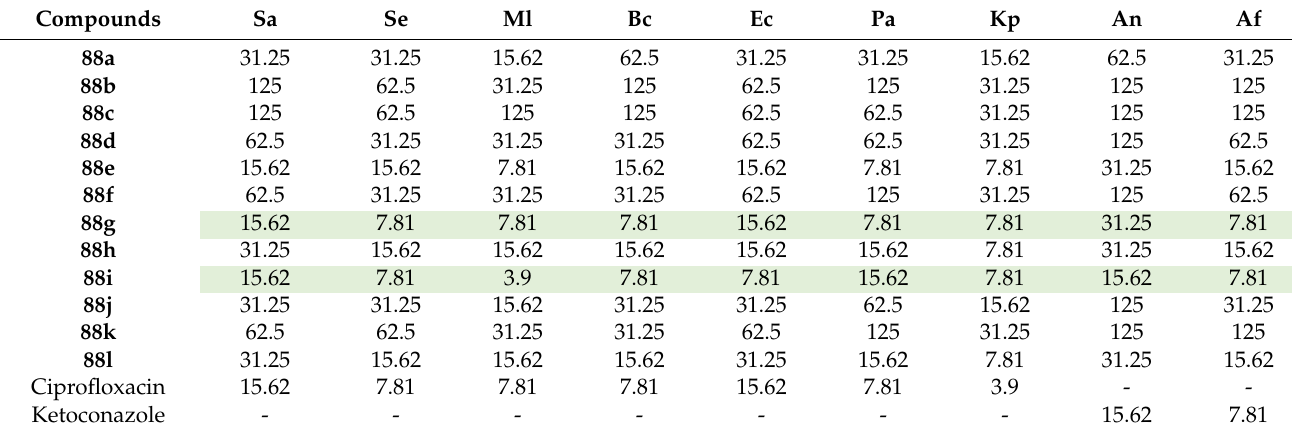
Table 10. Minimum inhibitory concentration in µ g mL − 1 of the compounds 88a – 88l